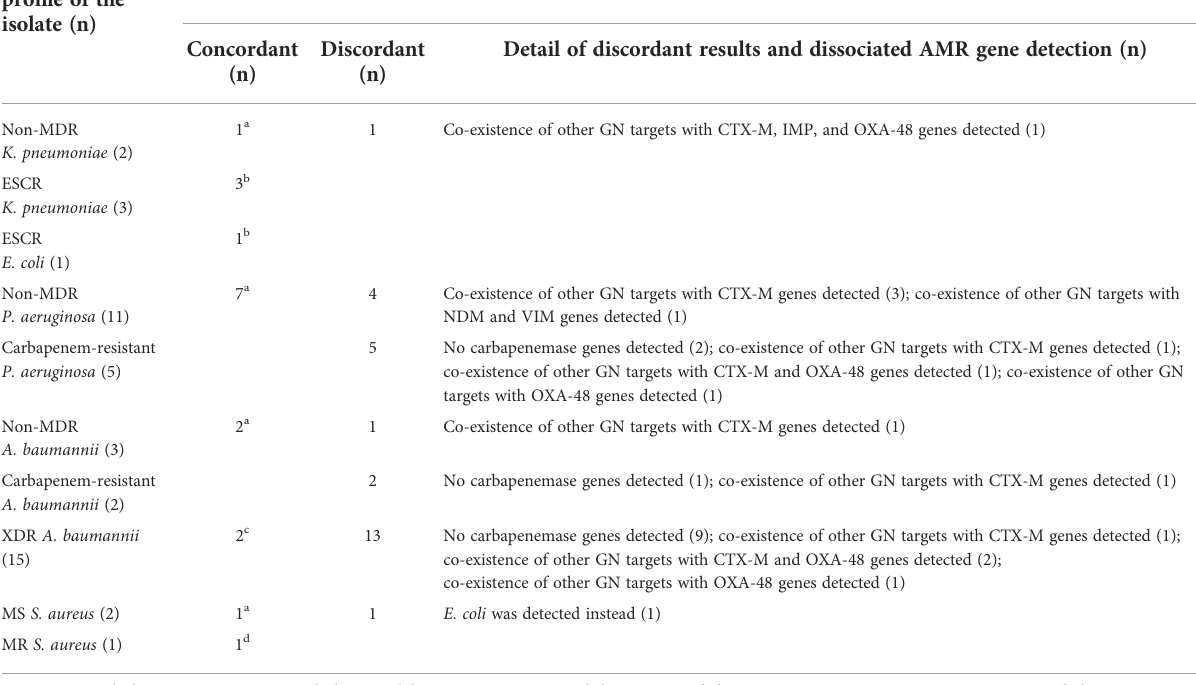
TABLE 6 Number of concordant and discordant results of the AMR gene detection by BioFire FilmArray pneumonia panel plus assay compared to the phenotypic antimicrobial susceptibility testing pro fi le of the bacterial isolate. Phenotypic AST pro fi le of the isolate